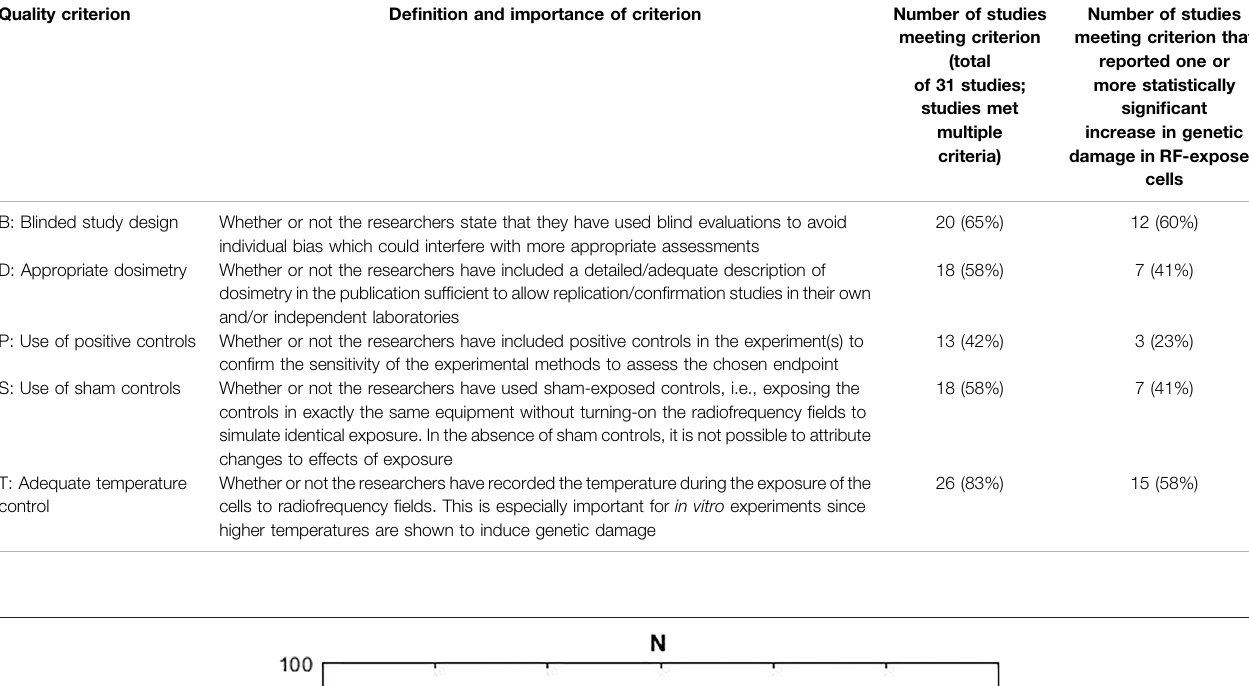
TABLE 1 | Risk of bias (RoB) criteria.